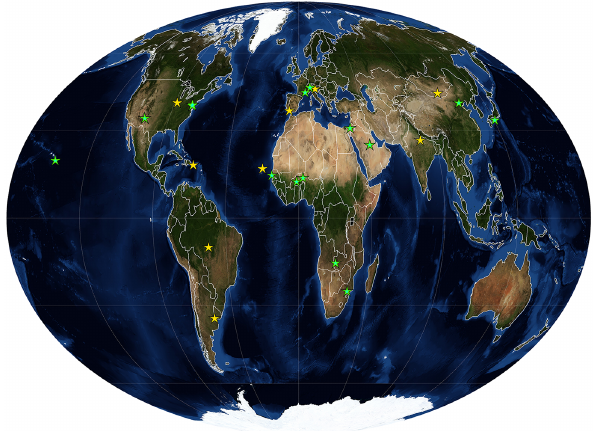
Figure 2. The AERONET stations used for estimating the uncer- tainty caused by limited/different temporal sampling and validat- ing the satellite-retrieved AOT trends in this study. The yellow and green stars denote the AERONET stations with continuous yearly data for more than 3 and 5, respectively. These stations are listed on the Tables 2 and 4,